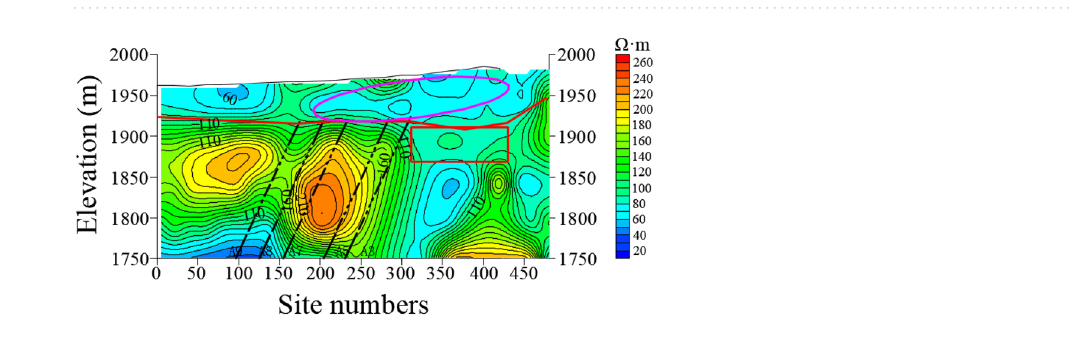
Figure 9. The resistivity profile of the TEM of L23.